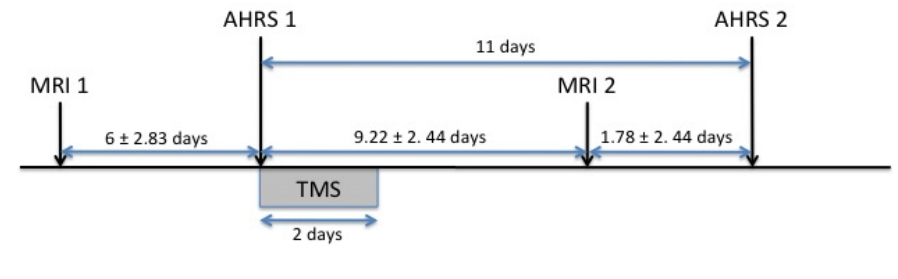
Figure 1: Time frame of the paradigm. MRI 1, first fMRI session; MRI 2, second fMRI session; AHRS 1, first AHRS assessment; AHRS 2, second AHRS